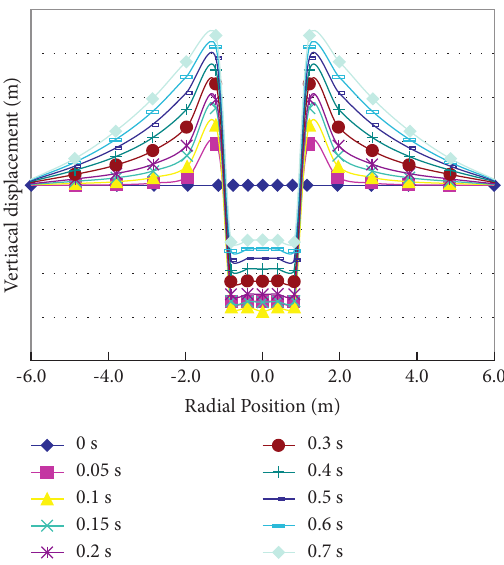
Figure 17: Shapes of ramming pits at different times.